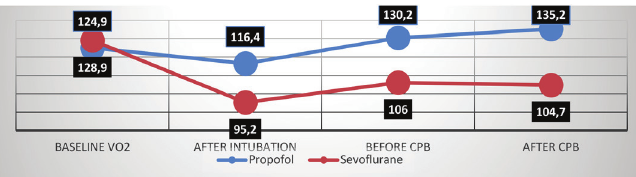
Figure 5 - Change in oxygen consumption before anaesthesia and during